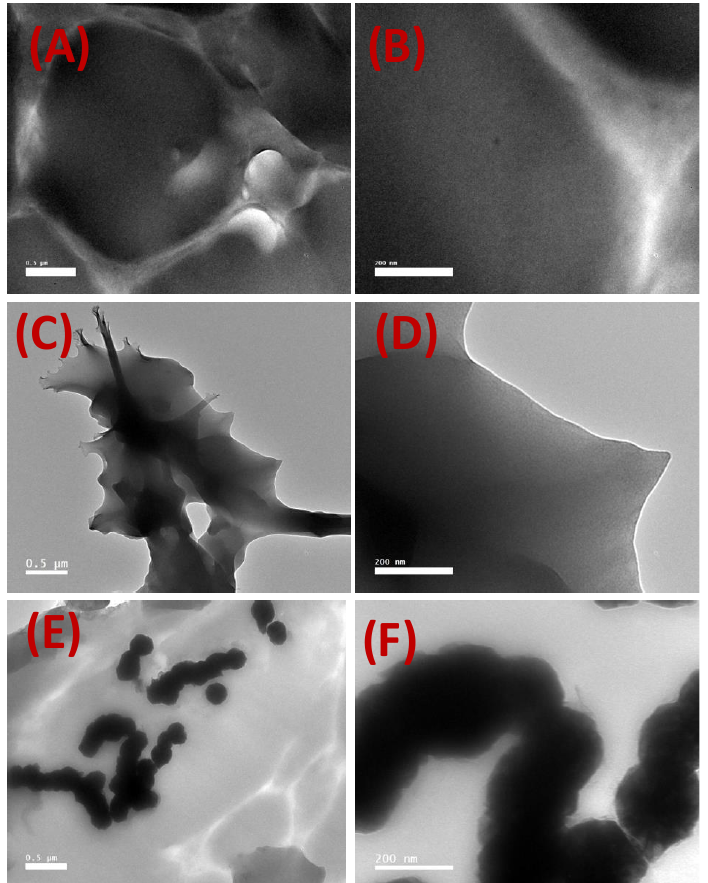
Figure 6. TEM images (0.5 µm and 200 nm bar scale) of the blank cellulose acetate (CA) ( A and B ) and the magnetic mixed CA matrix membranes prepared using Fe 10 Ni 90 ( C and D ) and Fe 20 Ni 80 alloys ( E and F ), respectively, inside the epoxy blocks.